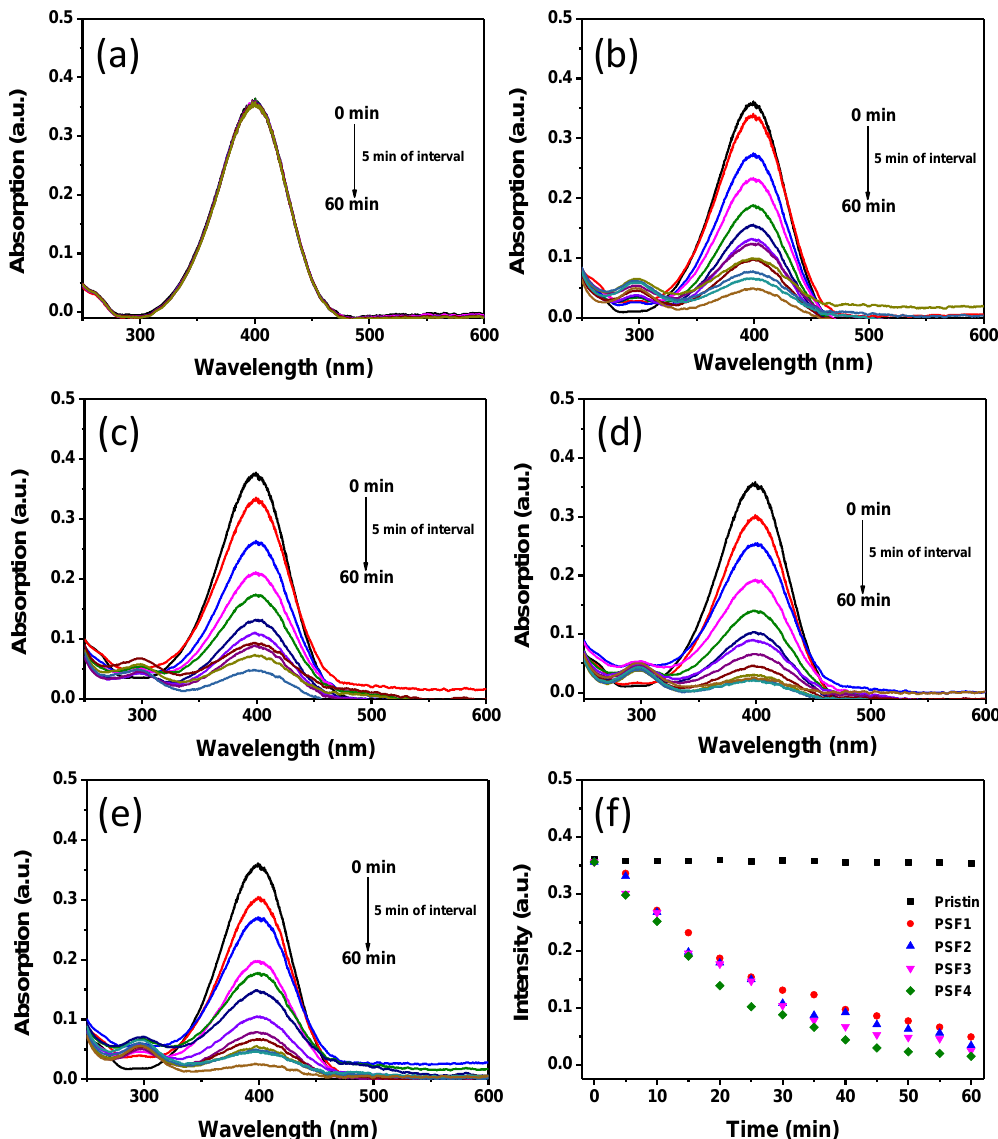
Figure 8. Evolution of UV-vis absorption spectra of 4-nitrophenol solution after NaBH 4 solution in the presence of the different fabrics: ( a ) pristine fabric; ( b ) PSF1; ( c ) PSF2; ( d ) PSF3; and ( e ) PSF4. ( f ) Plots of the peak intensity as a function of reaction time in the presence of different silk fabrics.